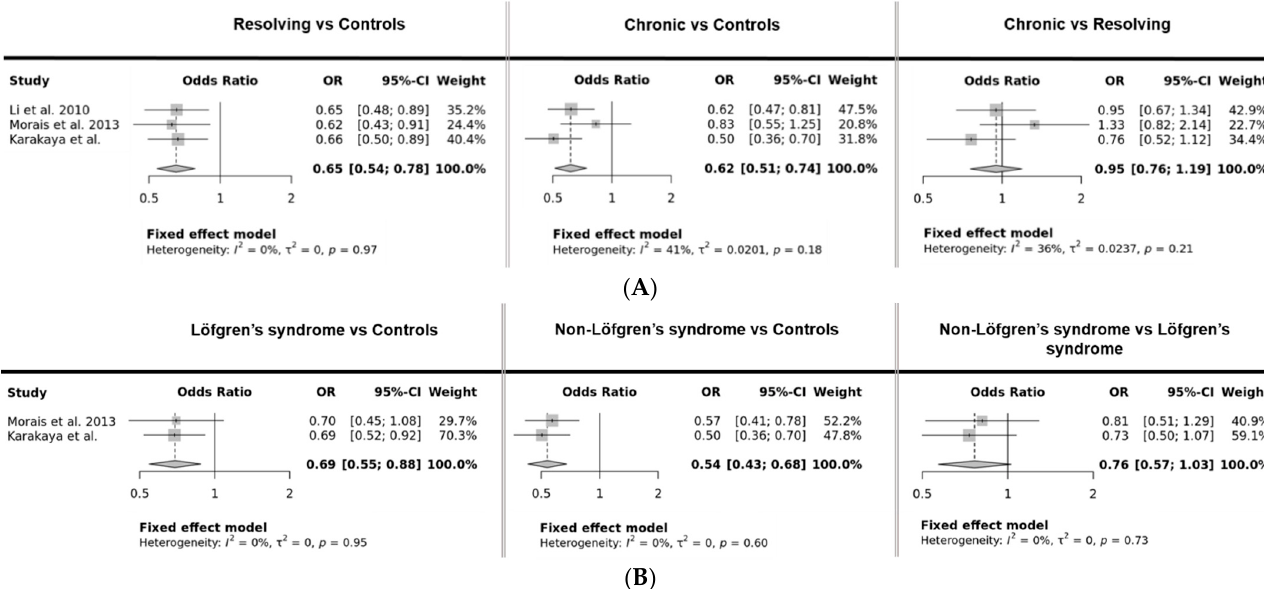
Figure 2. Meta-analysis for the studies of ANXA11 rs1049550 and phenotypes of Sarcoidosis. ( A ) Forest plot of the results for resolving and chronic sarcoidosis patients. ( B ) Forest plot of the results for Löfgren’s syndrome and non-Löfgren’s syndrome patients. Dotted line represents the odds ratio from the combined analysis. OR: Odds ratio, 95% CI: 95% confidence interval.